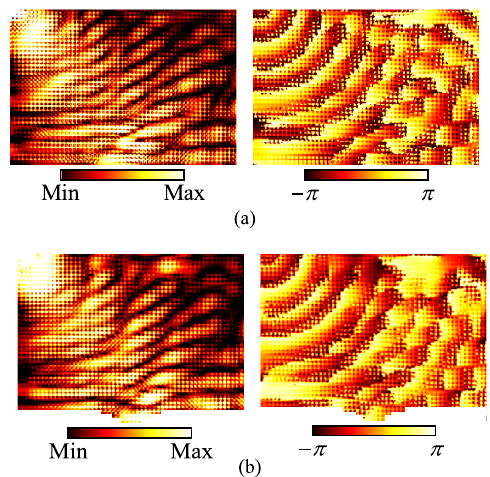
Fig. 26. Measured complex electric near- fi eld distributions with a point source at the top corner (Position B in Fig. 19) at 2.60 GHz. Left: Amplitude. Right: Phase. (a) With the groove illusion medium. (b) With the original groove.